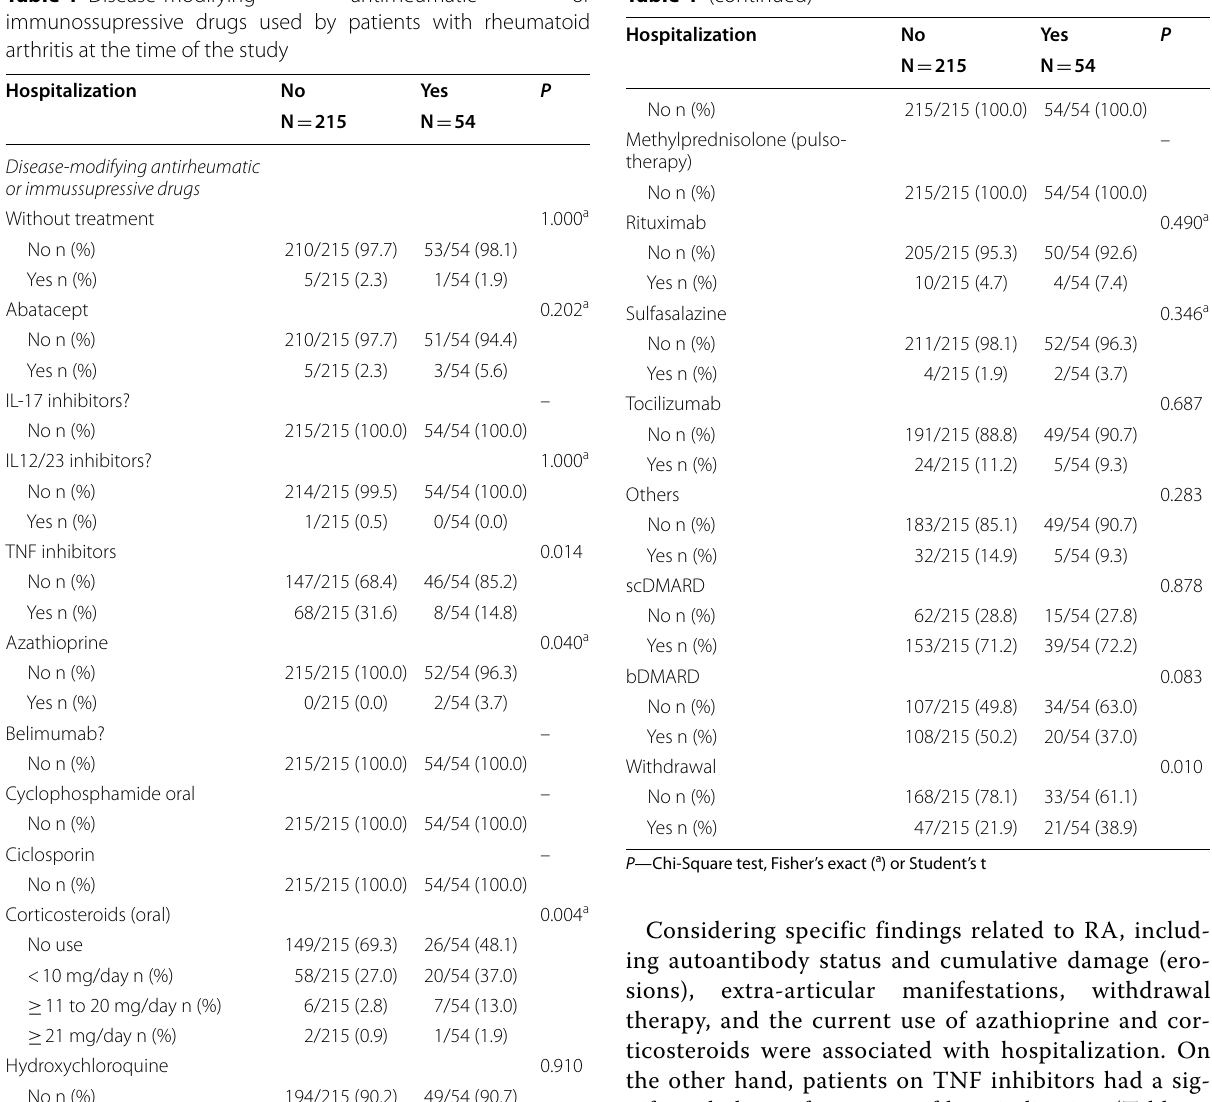
Table 4 Disease‑modifying antirheumatic